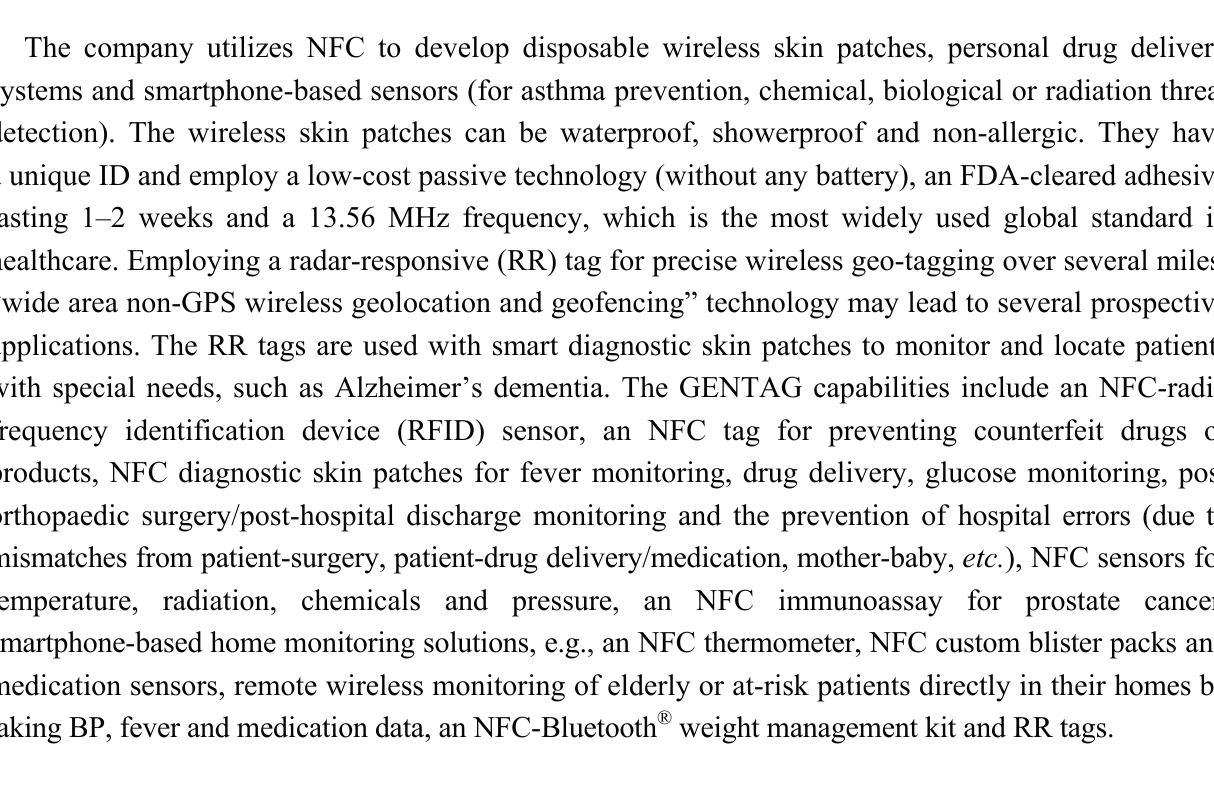
Figure 3. ( A ) NFC smart cell phone and ( B ) NFC SensorLinker by GENTAG, Inc. Images provided by Dr. John P. Peeters, GENTAG,